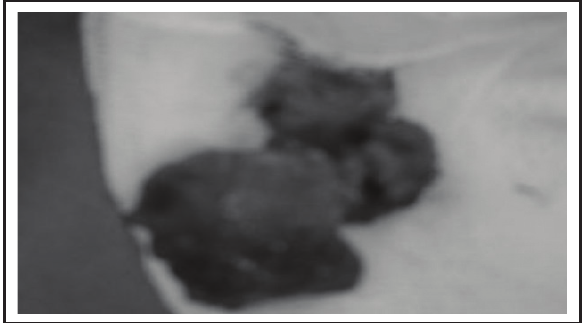
Figure 3. Showing gross well circumscribed, lobulated and solid mass measuring 4x3cm post excision .